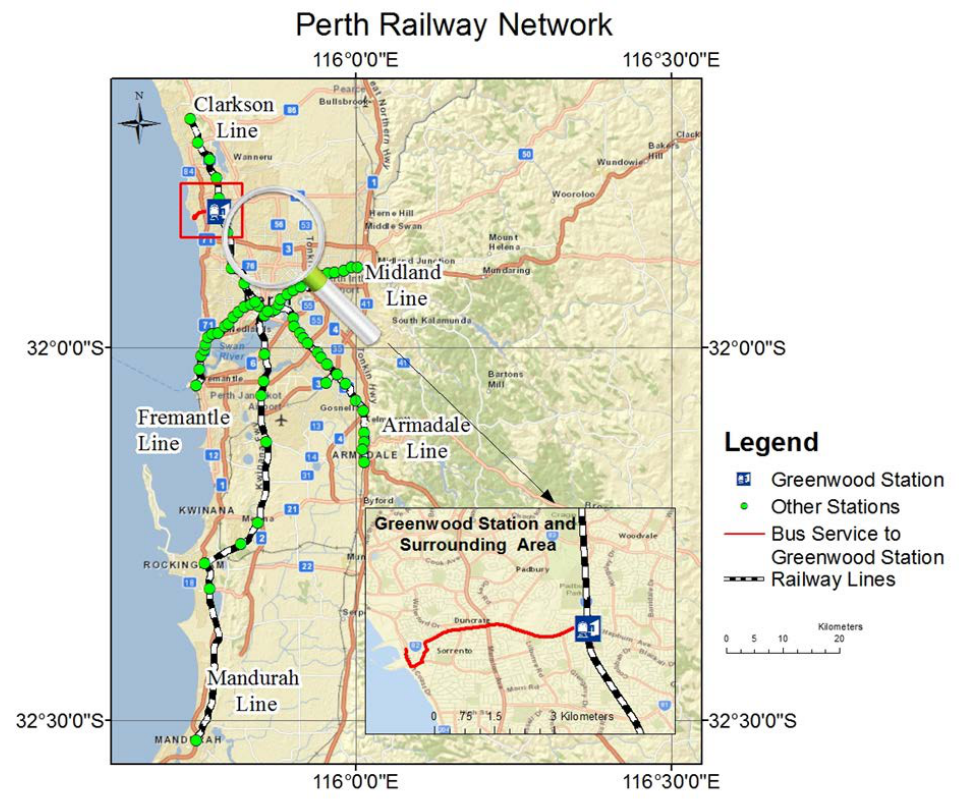
Figure 1. Study Area showing the location of Greenwood station on the Joondalup line in the context of Perth’s train line